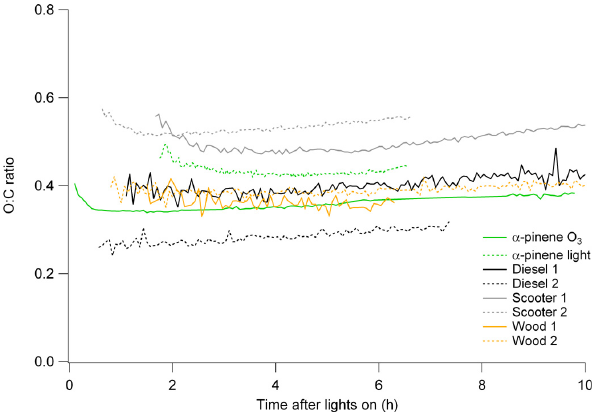
Fig. 4. O:C ratio vs. experimental time for the different sources. The time axis for the α -pinene ozonolysis experiment represents the time after the α -pinene addition to the chamber containing 500ppb